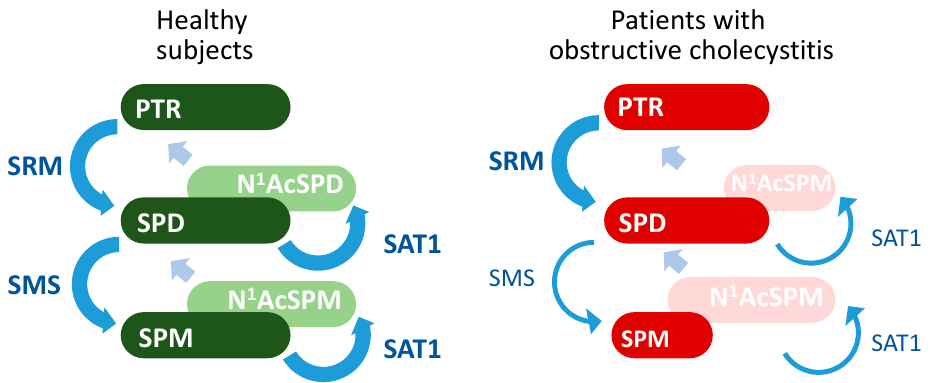
Figure 5. Graphical summary: The proposed difference in the metabolism of PA in healthy subjects and in patients with obstructive cholecystitis. Abbreviation as in Figures 2 and 3